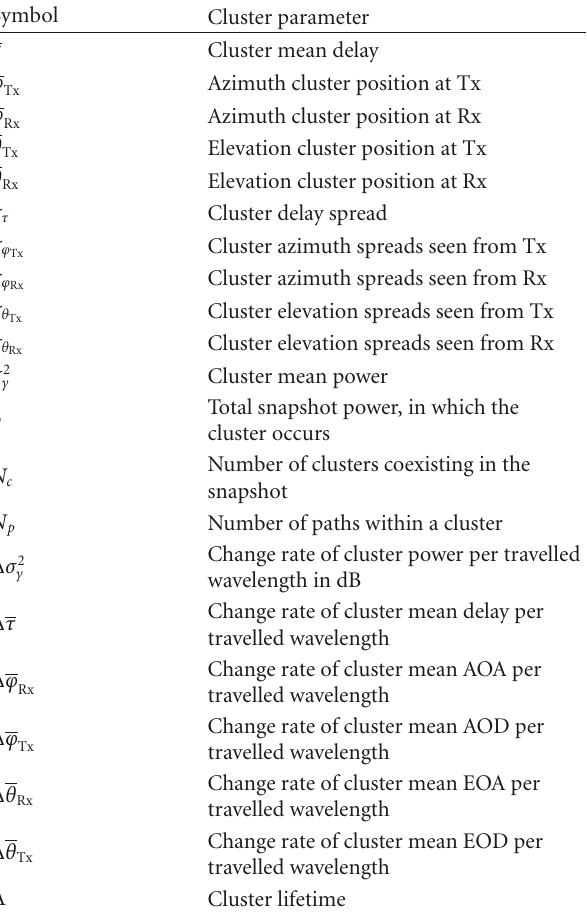
Table 1: Cluster parameters of a single cluster, contained in Θ c